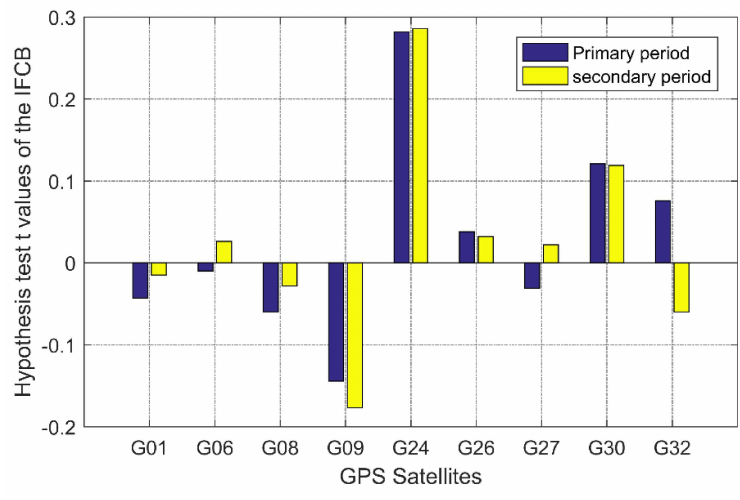
Figure 5. Hypothesis test t values of the IFCB.